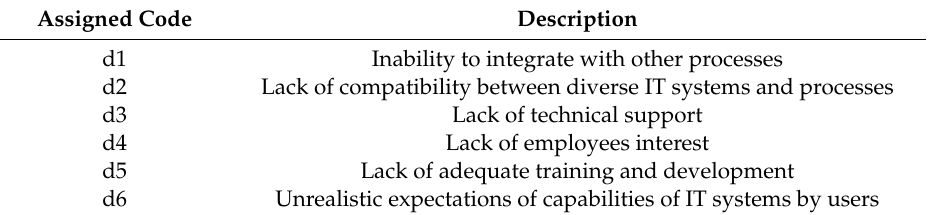
Figure 5. Independent fault tree analysis for probable causes leading to technological barriers (T). Table 8. Assigned codes and descriptions for basic events that lead to technological